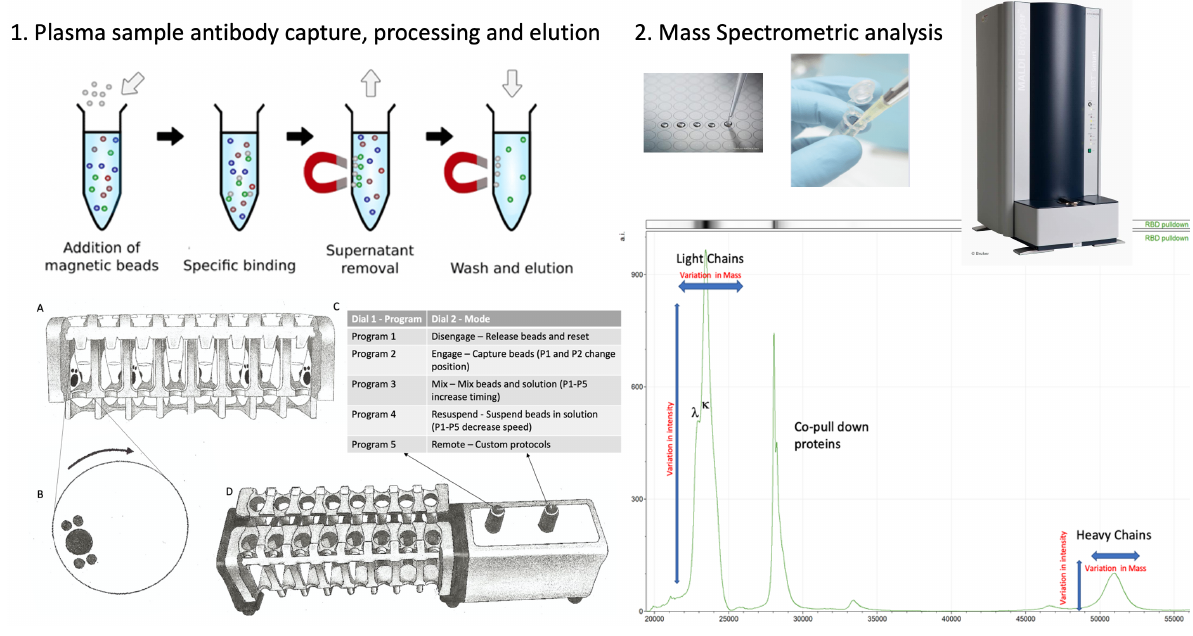
Figure 1. A schematic of the capture and elution of binding proteins, such as immunoglobulins, is illustrated in panel 1 . Plasma samples are mixed with magnetic beads coupled with nucleocapsid (N protein), stabilised complete spike (spike protein) or G protein. The magnetic particle processing rack can simultaneously process 16 samples in Eppendorf tubes ( A ). Using rotating discs containing magnets ( B ) on either side of the sample allows capture and removal of denuded sample, mixing and efficient wash off of non-specific absorption and final elution of the capture binder proteins ( C , D ) in a consistent standardised process. The eluted samples are spotted onto a MALDI-ToF mass spectrometry plate along with MALDI matrix and subjected to mass spectral analysis following a standardised protocol and settings. Raw data are exported and analysed to give precise measurements of molecular masses of the eluted binder/complex proteins (e.g., immunoglobulin light and heavy chains), along with intensity measurement for relative quantification purposes (panel 2